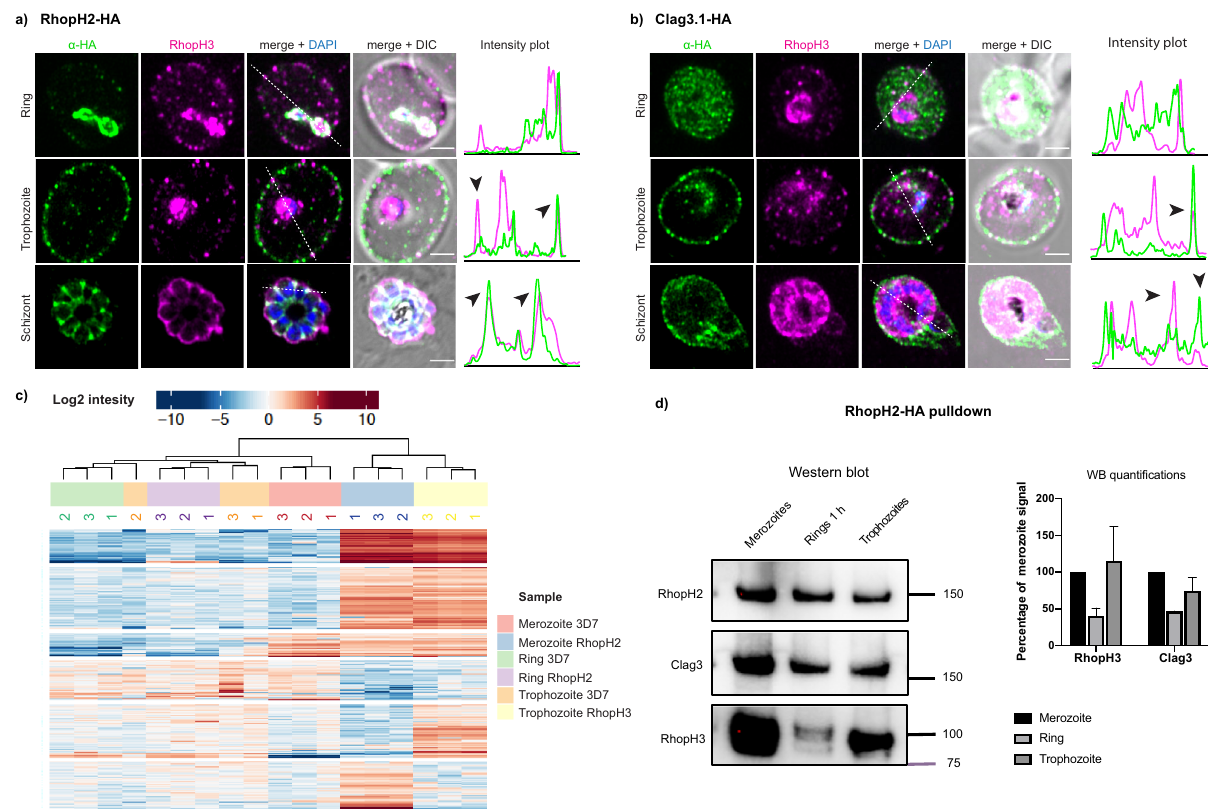
Fig. 4 RhopH complex reassociates following RhopH2 and RhopH3 export in trophozoite stage. a Super-resolution images showing colocalization of RhopH2-HA and RhopH3 during parasite development. Intensity plots along the white broken line show lack of colocalization at the ring stage, black arrows point at the points of colocalization on the erythrocyte surface and in the rhoptry. Scale bar 2 µ m. b Super-resolution images showing colocalization of Clag3.1-HA with RhopH3 during parasite development. Intensity plots are shown along the white broken line that shows lack of colocalization at the ring stage, black arrows point at the points of colocalization on the erythrocyte surface and in the rhoptry. Scale bar 2 µ m. c Heat map of the mass-spectrometry analysis from RhopH2-HA immunoprecipitation from developmental stages. d Immuno-blot (left panel) and quanti fi cation (right panel) of RhopH3 and Clag3 from RhopH2-HA immunoprecipitation of developmental stages. Error bars show SD from three biological replicates. Full blots shown (Supplementary Fig.